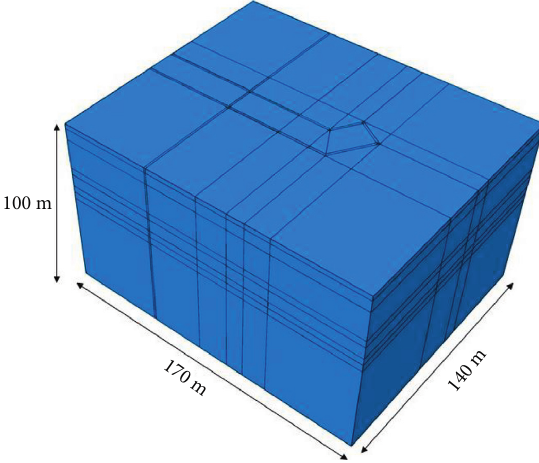
Figure 16: Finite element analysis